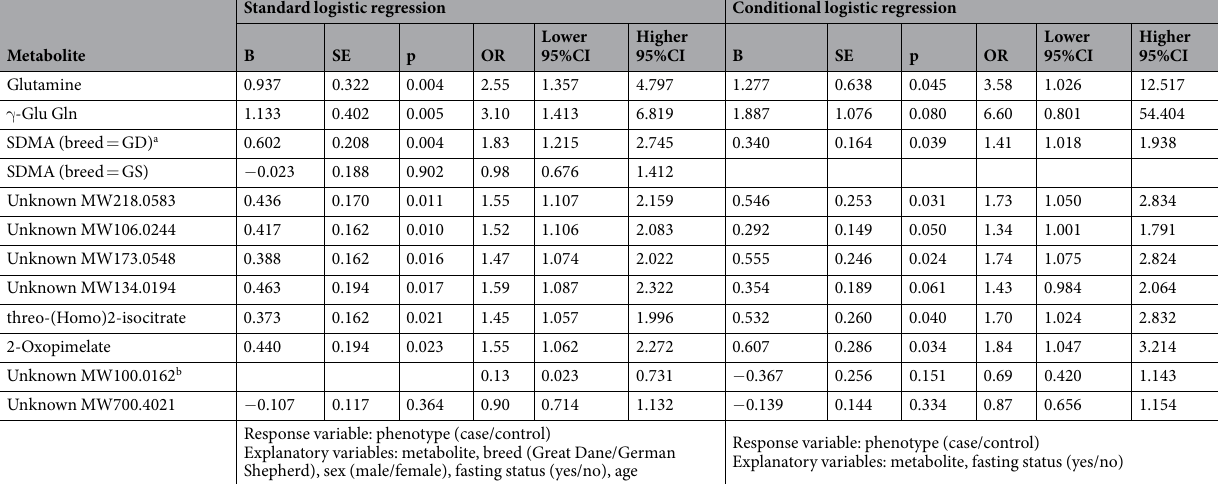
Table 2. Results of standard and conditional logistic regression analyses for metabolites that were potentially associated with canine fearfulness according to Mann-Whitney U-test (p FDR < 0.05). Metabolic features having Mann-Whitney U FDR-corrected p-values < 0.05 but showing poor chromatographic peak shape and/or MS/MS fragmentation were excluded from logistic regression analyses. B = coefficient, SE = standard error, OR = odds ratio, CI = confidence interval, γ -Glu Gln = γ -glutamylglutamine, SDMA = symmetric dimethylarginine, GD = Great Dane, GS = German Shepherd DF = 1 a Interaction with breed (p = 0.035) in the standard logistic regression analysis. b Interaction with age (p = 0.045) in the standard logistic regression analysis. OR is presented at the lowest age (18 months). OR multiplies with coefficient e 0.0231 when age grows with one unit. OR is < 1 at all ages but turns into non-significant at age 86 months or more. Maximum likelihood estimates not shown because of interaction complexity.